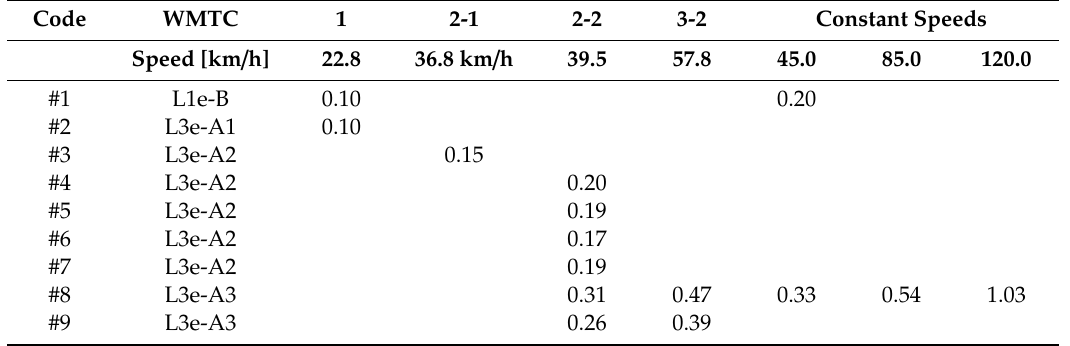
Table A1. Average exhaust flow rates [m 3 / min] normalised to 0 ◦ C and 101.3 kPa over various